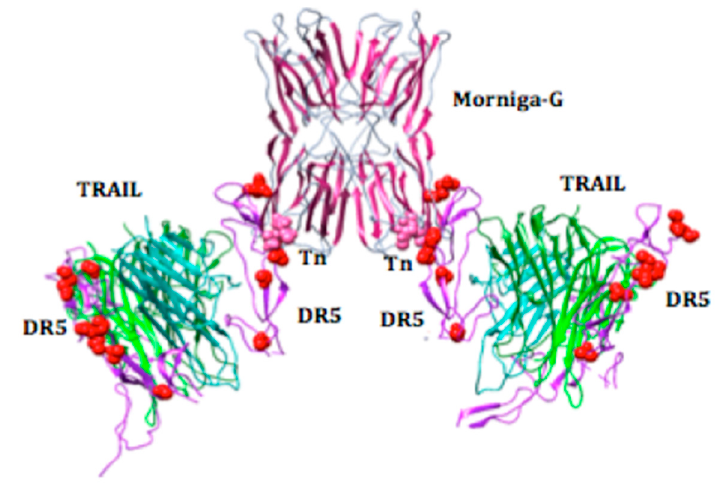
Figure 7. Morniga-G could facilitate the aggregation of Trail-DR5 complexes. Simulation drawn from docking experiments, showing how Morniga-G could facilitate the dimerization/aggregation of the TRAIL/DR5 complexes (TRAIL trimers in green/DR5 in purple) via the specific recognition of Tn antigen associated to Thr131 (colored pink) of DR5 monomers. Similarly, the lectin could facilitate the aggregation of the TRAIL/DR5 complexes via specific interactions with Tn antigen associated to Thr 130 of DR5.